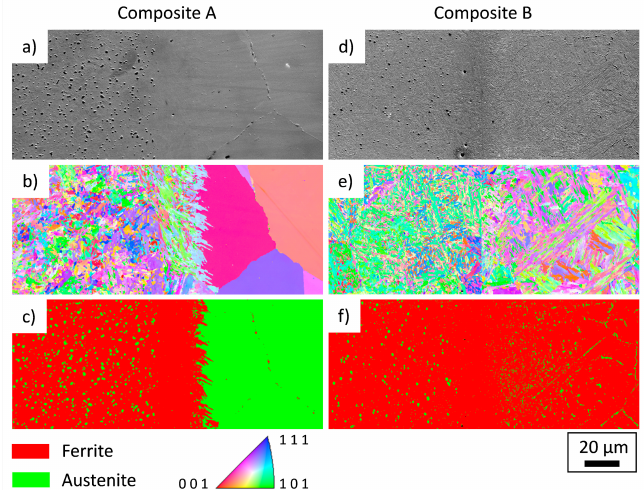
Figure 5. EBSD images showing the area near the interface of composite A ( a – c ) and composite B ( d – f ). ( a , d ) SEM images, ( b , e ) inverse pole figure maps, ( c , f ) phase maps. Both cold work tool steels showing a martensitic microstructure with a homogeneous distribution of globular carbides on the left side. The martensitic interface is free of coarse carbides for both composites. The PH steel (composite A) shows an austenitic microstructure with carbides at the grain boundary and the maraging steel (composite B) shows a martensitic microstructure with carbides in the matrix and at grain